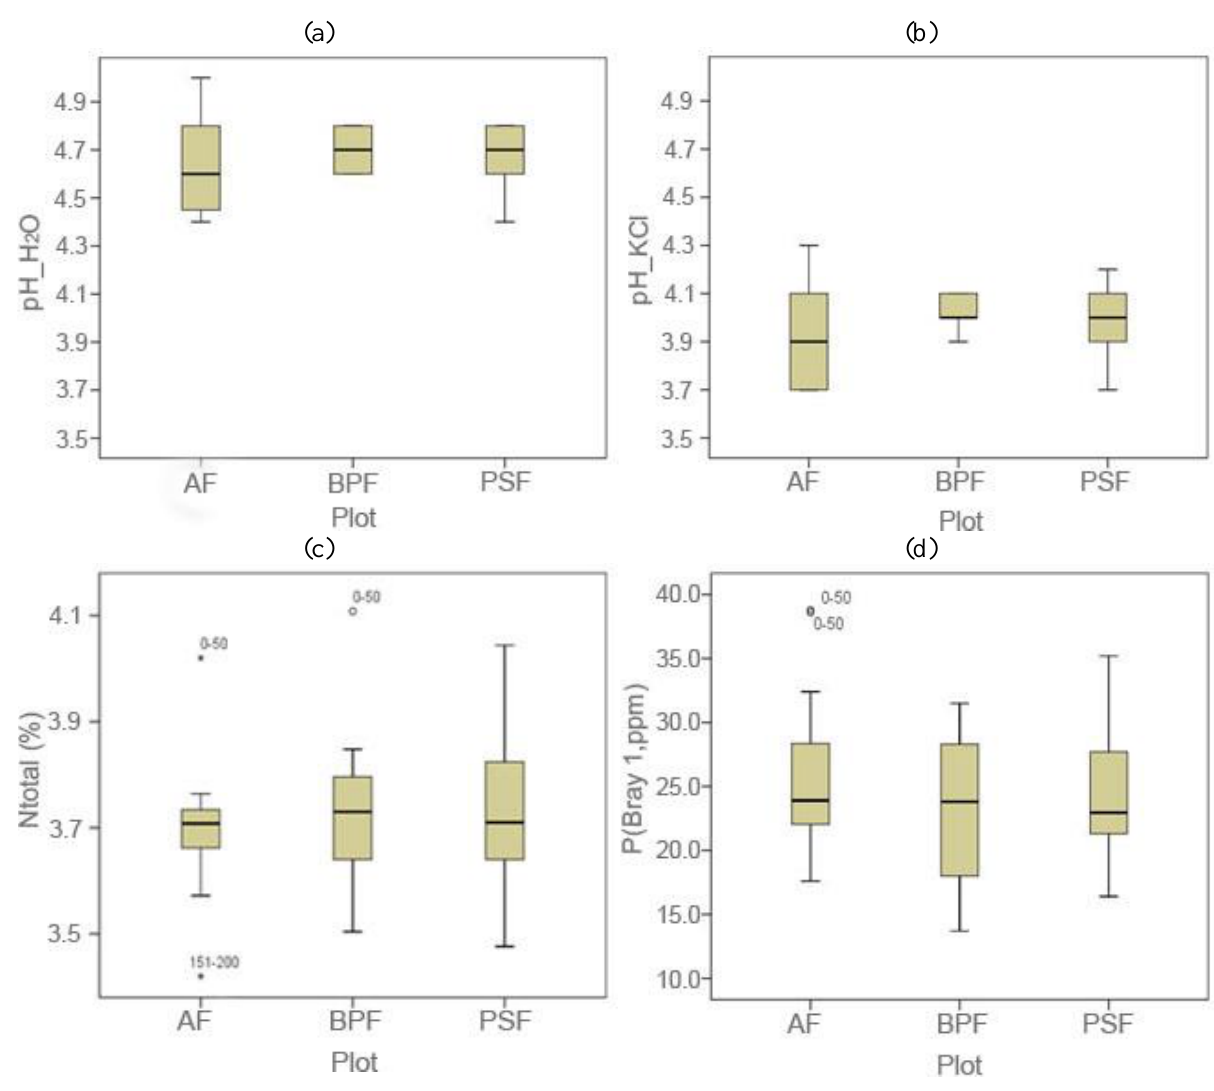
Figure 6. Peat properties of pH (H O and KCl), total N and available P from peat swamp forest (PSF-2 2 plots), burned peatland (BPF, 2 plots from peatland burned in 1997 and 2004) and agroforestry (AFJ; 3 plots with jelutung+rubber, jelutong+ N. lappaceum and jelutung+ Acacia , respectively). a) pH H c) N total, d) P